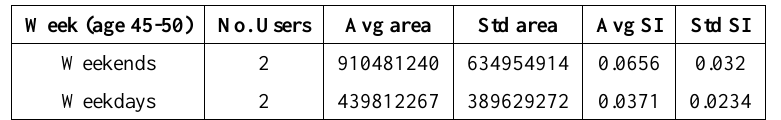
Table 10. Average and standard deviation of area and shape index of users between 45-50 based on days of the week.